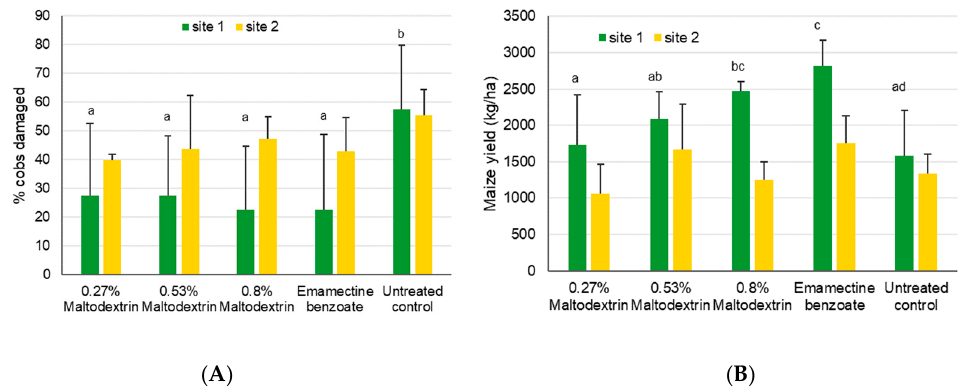
Figure 3. Mean maize cob damage induced by FAW + SD ( A ) and mean maize yields ( B ) after treatment with various concentrations of maltodextrin for site 1 near Wa, Upper West, Ghana, and site 2 near Accra, Ghana. Bars for yield at site 1 sharing the same letters are not significantly different from each other for the yield data, while missing letters indicate that no significant differences were found.